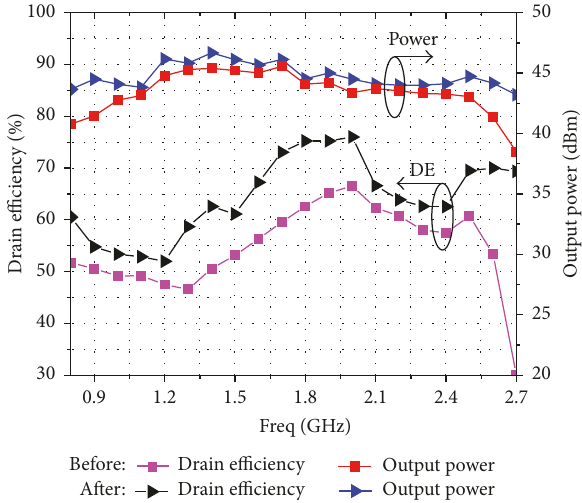
Figure 4: Measured drain efficiency and the output power before and after parasitic compensation.